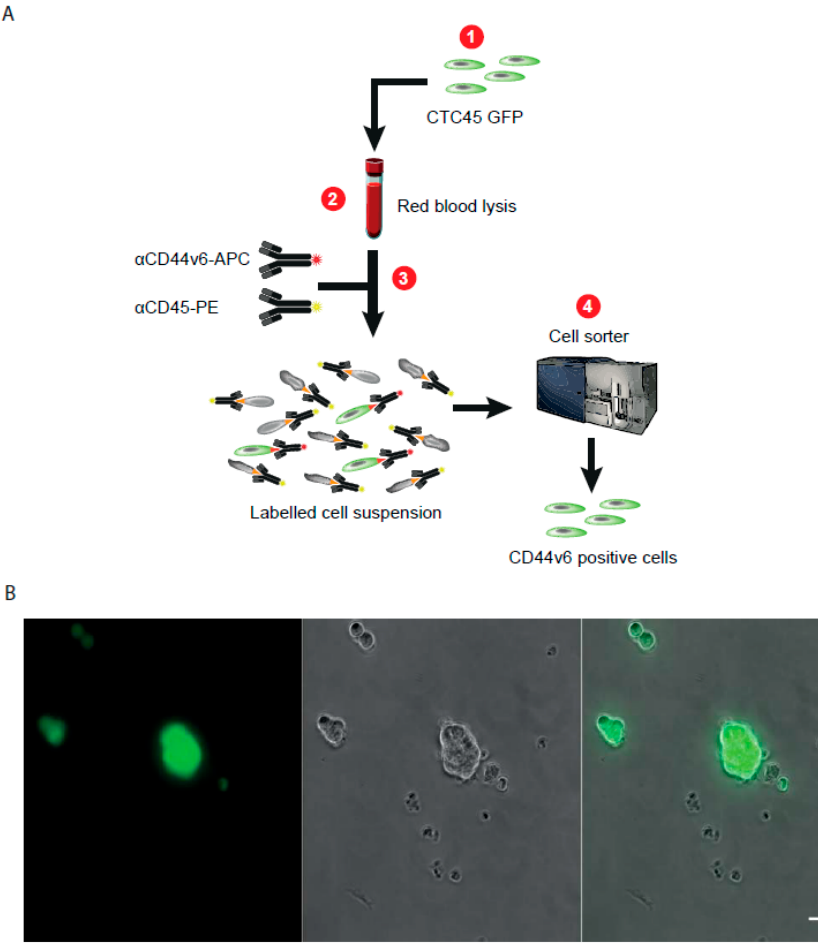
Figure 3. Cytometry-based isolation following CD44v6 staining efficiently discriminated tumor cells from hematopoietic cells. ( A ) Flowchart summarizing the strategy used to purify CTC in patient blood samples through fluorescent-activating cell sorting (FACS). Detailed protocol is described in the Materials and Methods section. ( B ). Photos of GFP-positive CTCs cultured after cell sorting following staining with an antibody directed against CD44v6, observed with a microscope (flu- orescent for the left photo and bright field for the middle one; the right photo is merged). Scale bars represent 50 µm. Protocols for the two approaches are detailed in the Material and Methods section. For the ensuing work, we preferred the cytometry strategy for cell isolation because of the noticeable contamination of CD45-positive cells with magnetic beads that rendered CTC fine enumeration impossible.